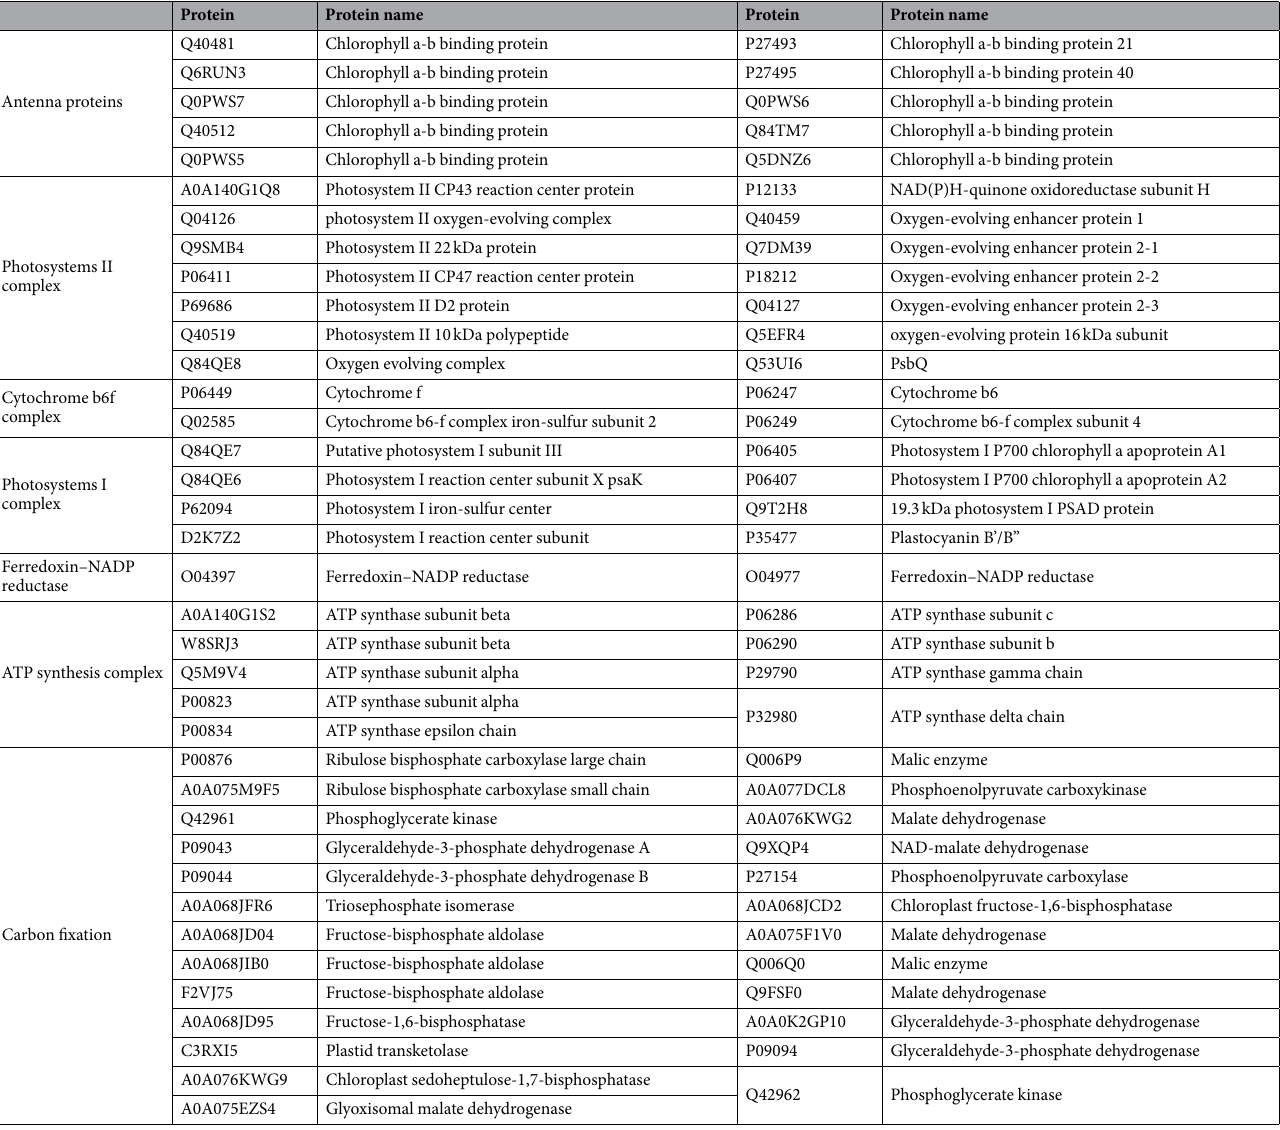
Table 2. Crotonylated proteins involved in photosynthesis